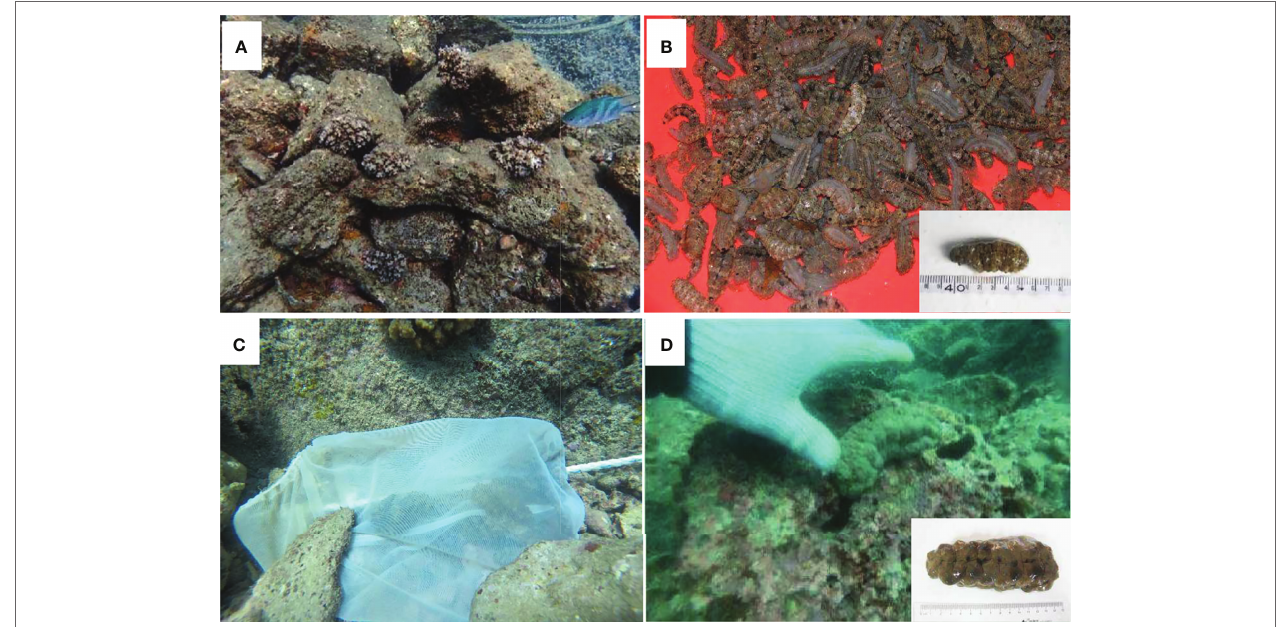
FIGURE 2 | The deployed volcano rocky artificial reefs with settled corals (A) . Sea cucumber Stichopus monotuberculatus juveniles in the hatchery (B) . The self- release mesh bag with juveniles in it (C) . A sea-ranched individual 8 months after release (D) . (photographed by Qiang